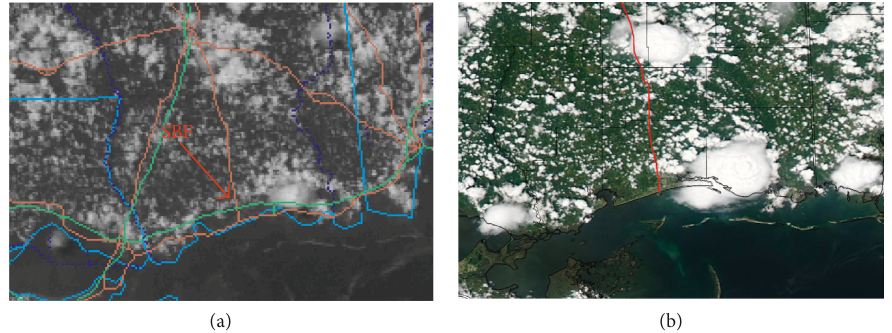
Figure 7: Visible imagery on 6 August 2014. (a) GOES near time of SBF intercept (1830 UTC; 1330 CDT) and (b) MODIS Aqua at 1915 UTC (1415 CDT).